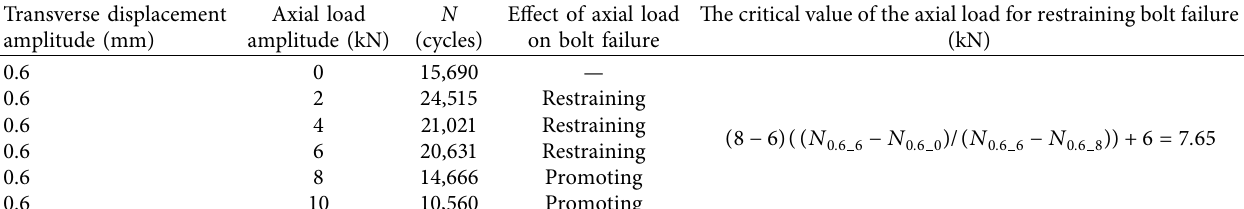
Table 3: Calculation of the critical value of the axial load for restraining bolt failure.